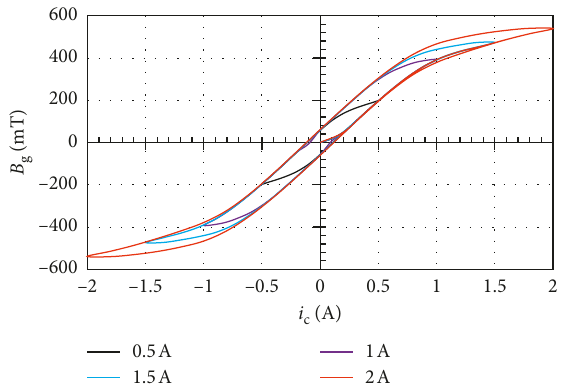
Figure 13: MR fluid contribution: calculated flux density vs. ex- citing current.